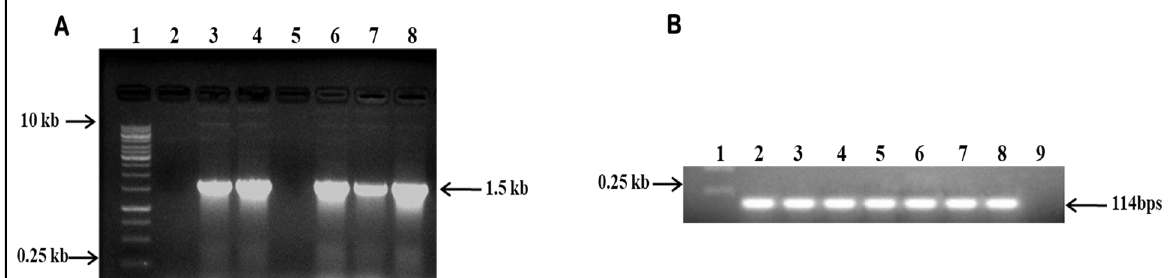
Figure 5. Syringe infiltration; plant leaves were infiltrated using syringe without needle on the ab- axial leaf surfaces.